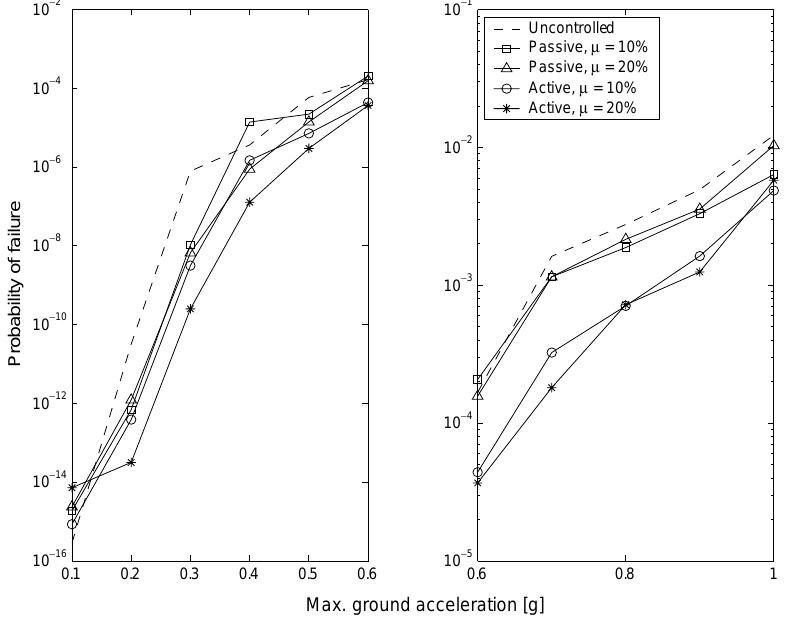
Fig. 5. Fragility curves of the rail for passive and active control schemes.